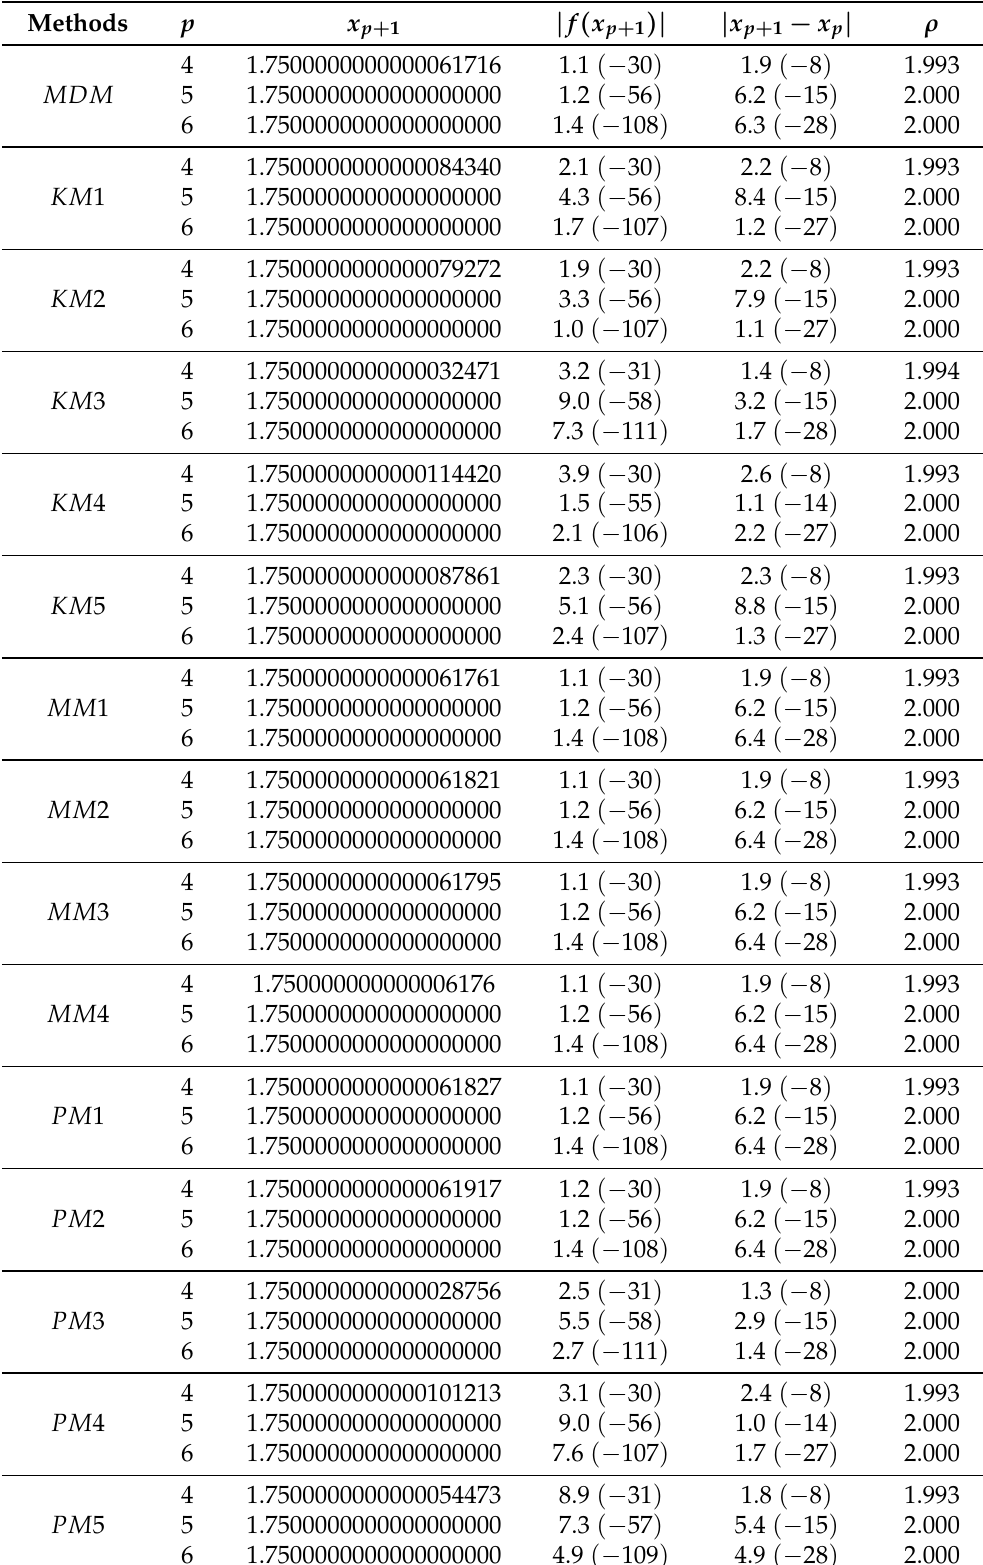
Table 4. Comparison of different iterative methods on Example